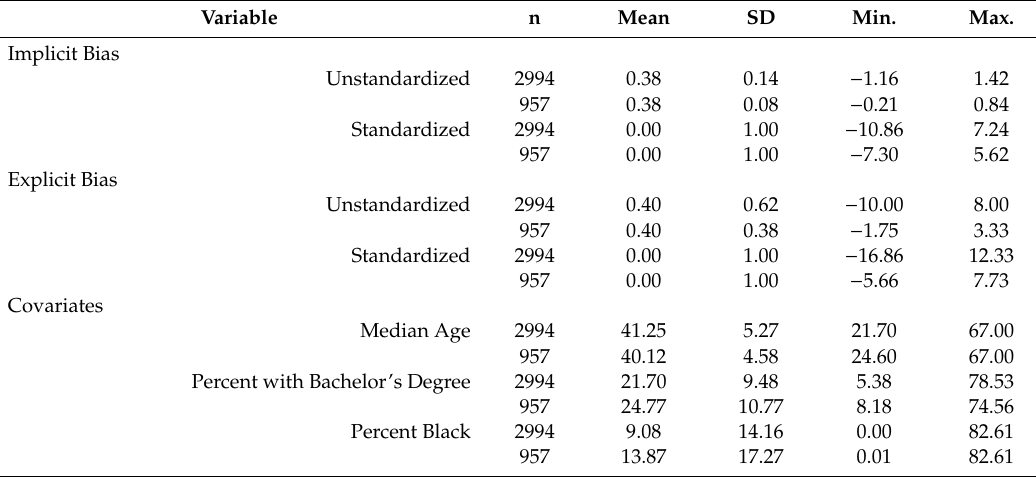
Table 1. US county-level distribution of racial bias, COVID-19 incidence and mortality rates, and socioeconomic, demographic, and political variables for the samples of 2994 counties (in models assessing overall rates using Johns Hopkins data) and 957 counties (in models assessing race-disaggregated rates using The New York Times (NYT)